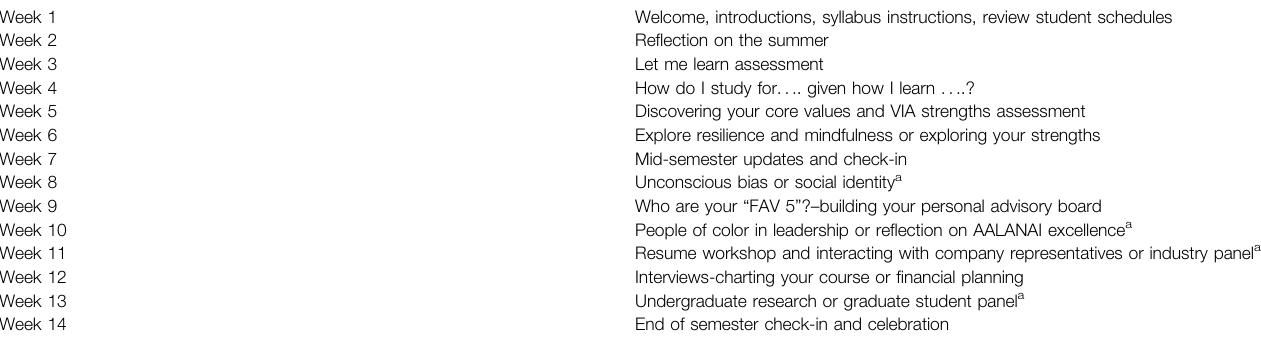
TABLE 3 | Fall Academic Success Seminar